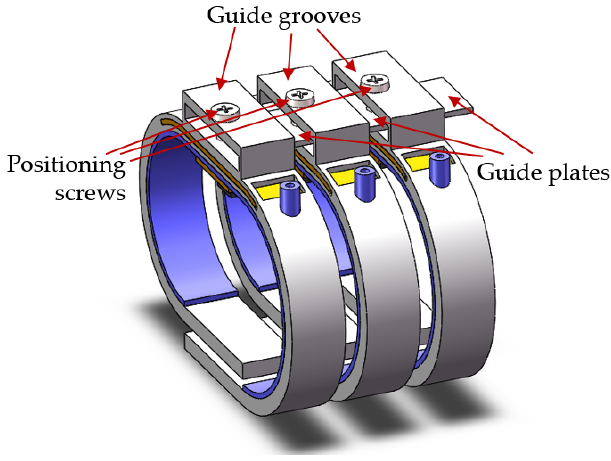
Figure 8. Components and structure of combined wristbands.